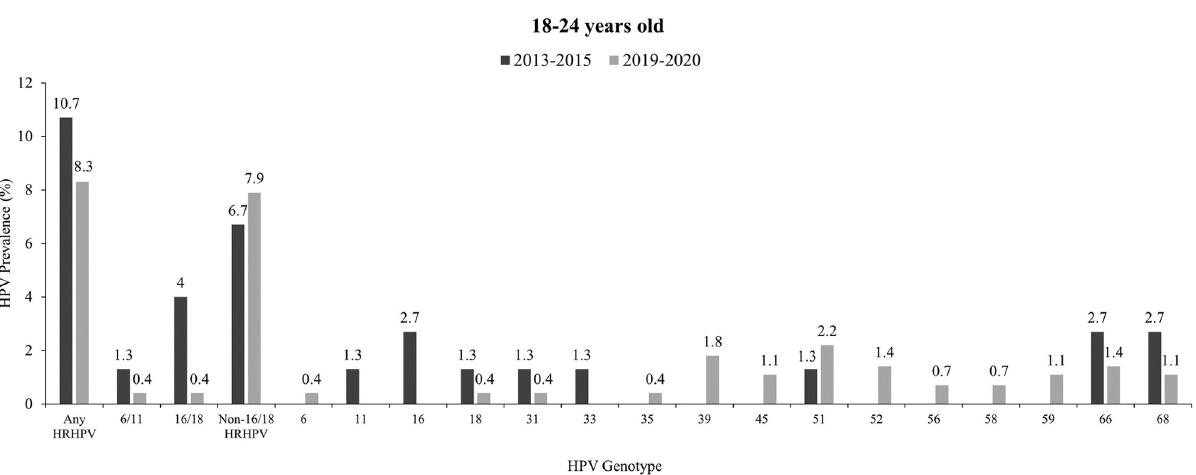
HPV genotypes between these study periods. Among women aged 35–45, there was no differ- ence in the prevalence for all HPV categories between 2013 and 2019. The detailed HPV preva- lence for both age groups across two study periods is shown in Table 2. HPV genotype distribution by age group across two study periods The distribution of HPV genotype according to age groups across two study periods is demon- strated in Figs 1 and 2. In 2019, non-16/18 HRHPV infections made up 95% (7.9% of 8.3%) of